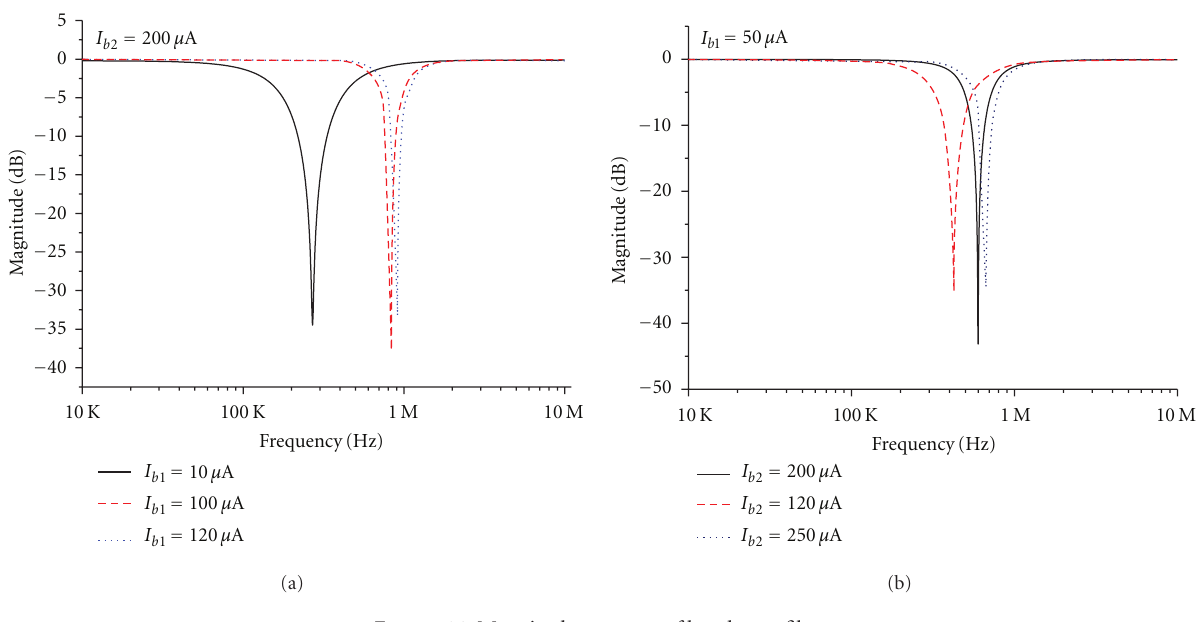
Figure 14: Magnitude response of band-stop